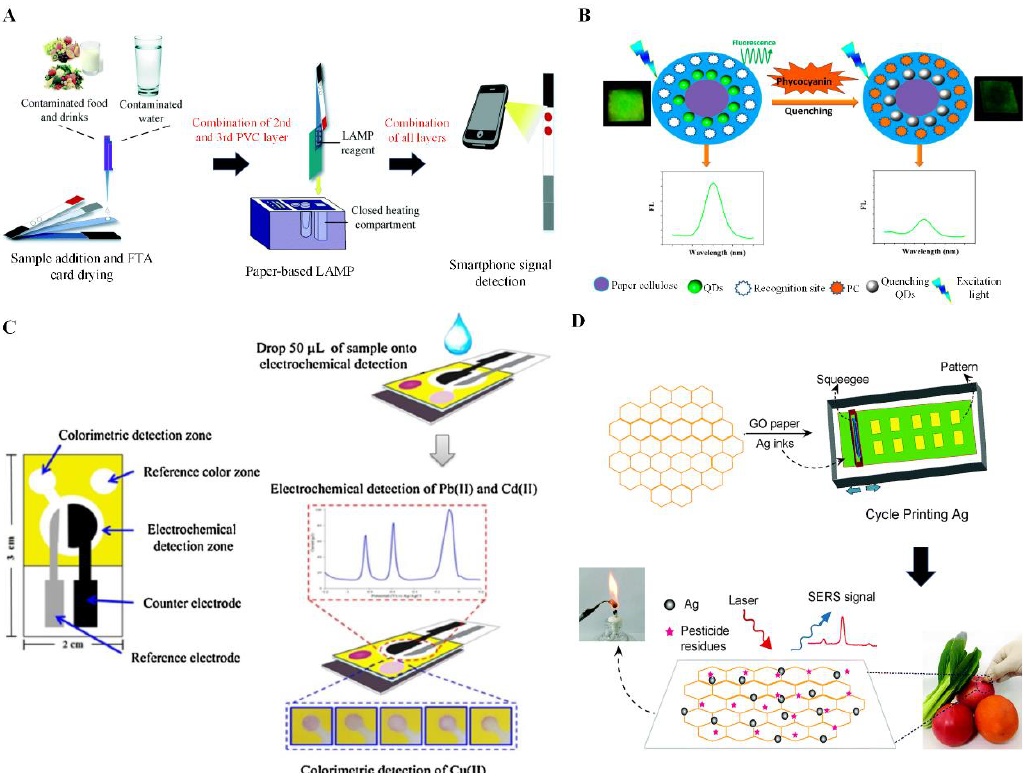
Figure 1. Emerging paper-based point-of-care (POC) devices for food safety analysis. ( A ) An integrated sample-to-answer paper-based colorimetric device was developed for the colorimetric detection of E. coli in contaminated food and drinks. Adapted with permission from [14] © Royal Society of Chemistry (2016). ( B ) A paper-based fluorescent device coupled with fluorescent quantum dots (QDs) and MIPs was introduced for the sensitive detection of phycocyanin (PC). Adapted with permission from [49] © ACS Publications (2017). ( C ) A paper-based electrochemical-colorimetric hybrid device was developed for multiplexed detection of food chemicals, including lead (II), cadmium (II) and copper (II) ions. Adapted with permission from [59] © Elsevier (2016). ( D ) A paper-based surface-enhanced Raman scattering (SERS) device was fabricated with the integration of graphene oxide (GO) and silver (Ag) nanoparticles for the detection of pesticide residues in foods. Adapted with permission from [61] © Royal Society of Chemistry (2018).